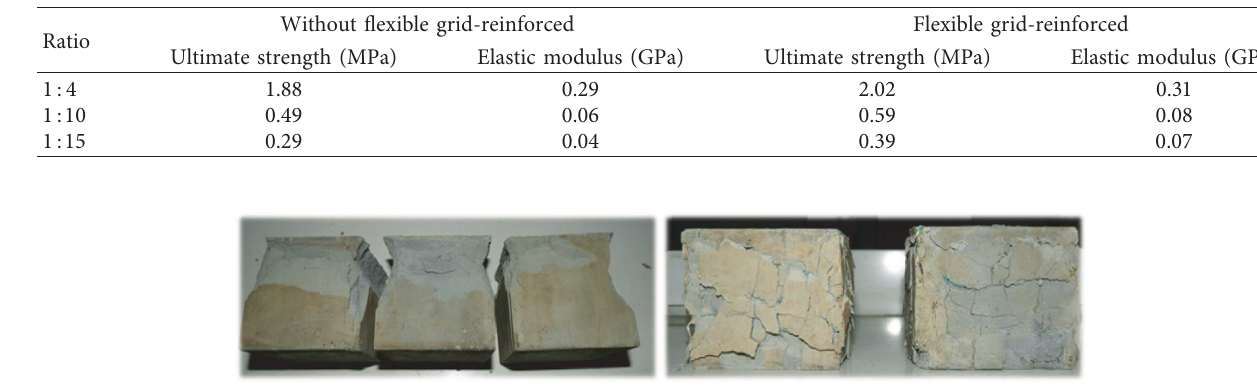
Figure 5: Comparison of filling failure modes before and after